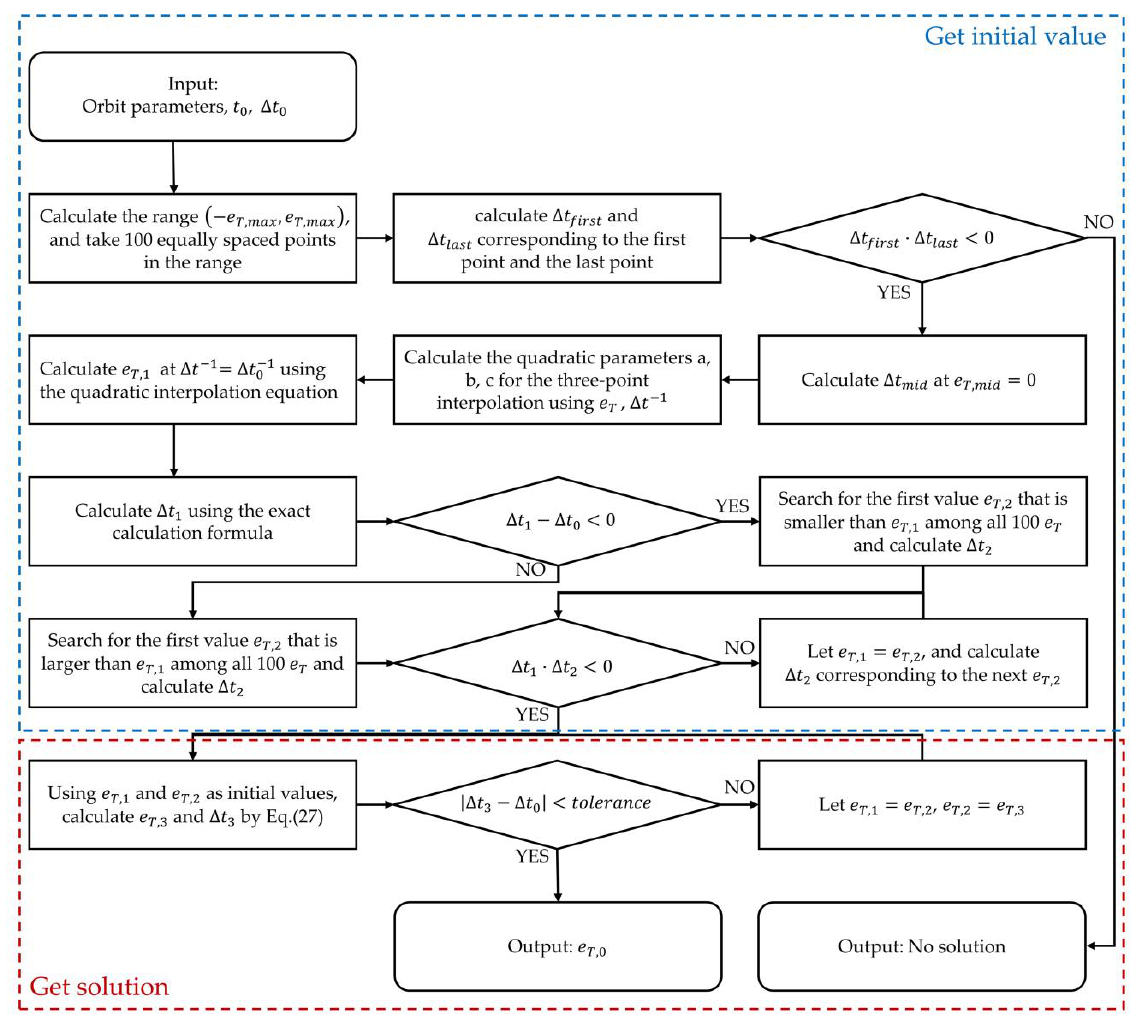
Figure 4. Flowchart of the quadratic interpolation chord cut algorithm.